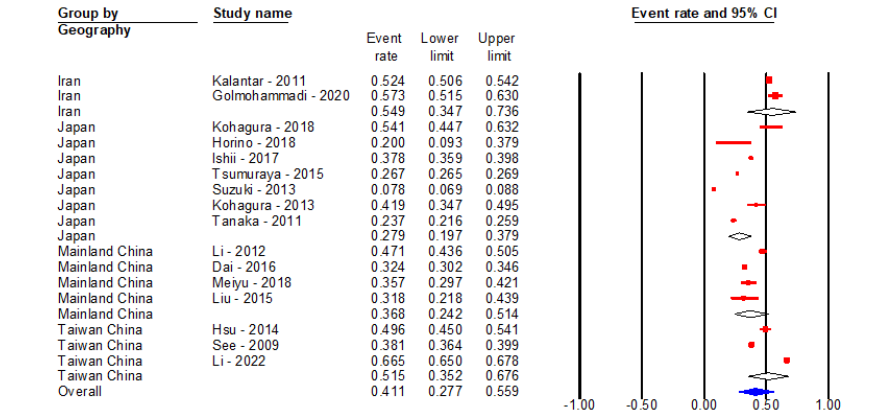
Figure 3. Subgroup analysis based on